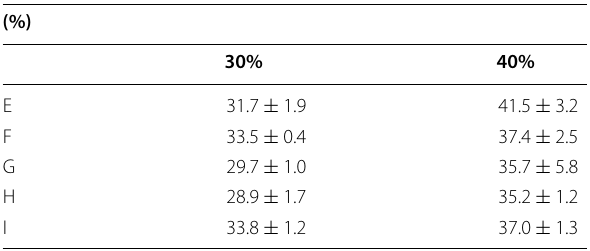
Table 6 Average of rUW at each target value in the “no tablet display” condition